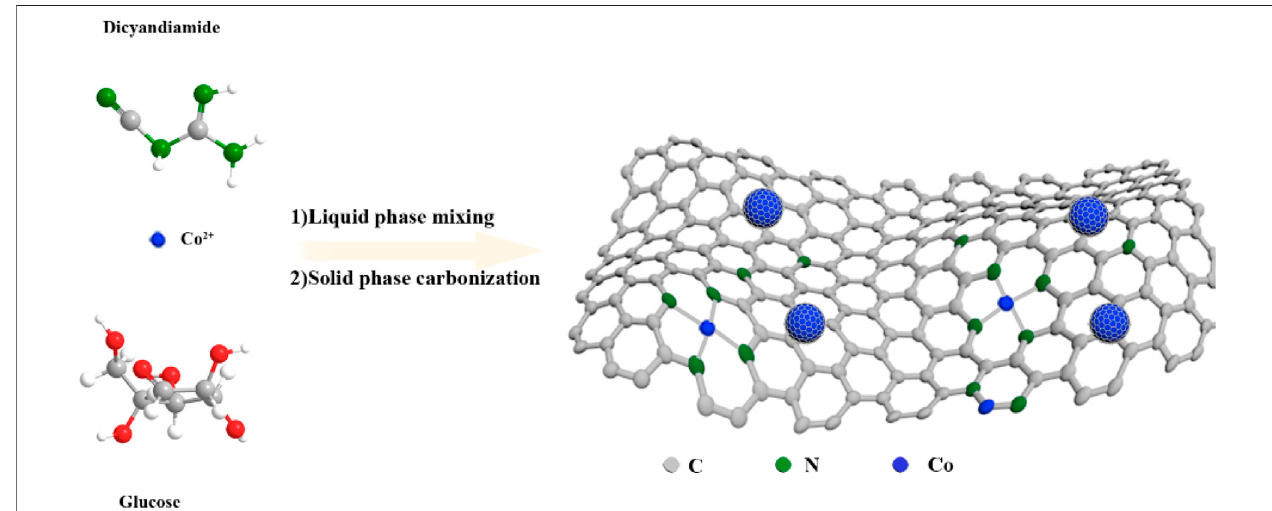
SCHEME 1 | The schematic illustration for the preparation of Co-N-C X